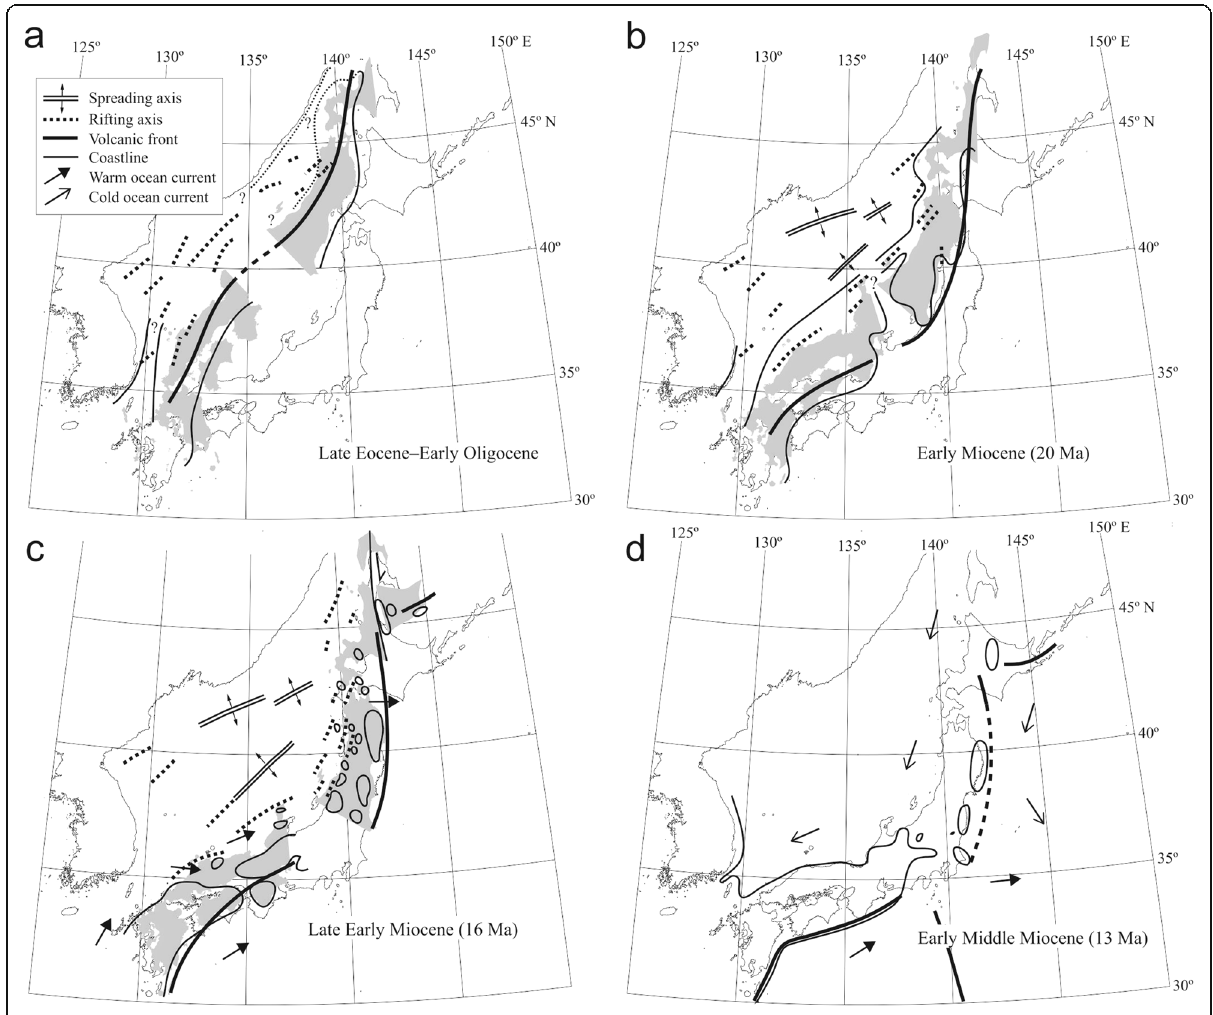
Fig. 2 Selected stages, showing the Paleogeographic evolution of Japan. Detailed description of the different stages is in the text. a : Continental arc stage, before 30 Ma. Subduction of (proto) Pacific plate has formed a large continental arc due to accretion and igneous activity at the margin of SE Asia. The first image already emphasizes the beginning evolution of a new rift system. b : This rifting stage is marked by a change in igneous activity and the onset of sedimentation related to basin evolution at Shimane peninsula. c : Peak rifting stage with the formation of new oceanic crust in the back-arc region and clockwise rotation of SW Japan into its current paleogeographic location ( d ) (from Kano